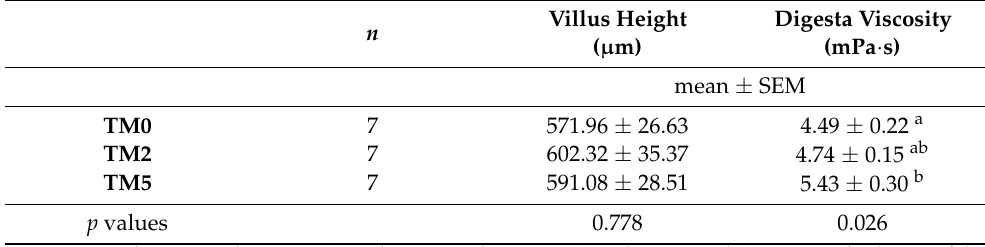
Table 3. Ileum villus height and ileum digesta viscosity.